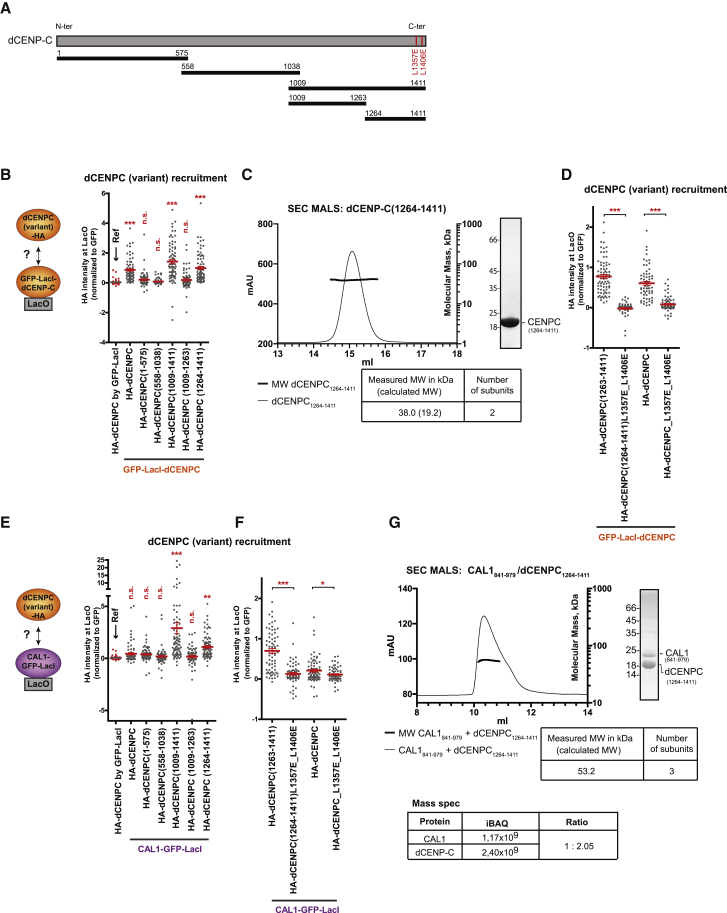
dCENP-C Dimerization Is Necessary to Interact with Monomeric CAL1 to Form a Trimer(A) The dCENP-C N-terminal, middle, and C-terminal regions used in this study are represented by black horizontal lines with numbers indicating amino-acid positions.(B) Experimental scheme and quantitation of normalized HA-tagged dCENP-C and dCENP-C fragment mean intensities at LacO upon tethering of GFP-LacI-dCENP-C or GFP-LacI (first lane).(C) SEC-MALS experiments performed with recombinant His-dCENP-C (1264-1411). Elution volume (ml, x axis) is plotted against absorption at 280 nm (mAu, left y axis) and molecular mass (kDa, right y axis). Tables show measure molecular weight (MW) and calculated MW. Mw/Mn = 1.001.(D) Quantitation of normalized HA-tagged wild-type and mutant dCENP-C fragment mean intensities at LacO upon tethering of GFP-LacI-dCENP-C.(E and F) Experimental scheme (E) and quantitation of normalized HA-tagged dCENP-C and dCENP-C fragment mean intensities at LacO upon tethering of CAL1-GFP-LacI (E and F) or GFP-LacI (E, first lane). (See also Figure S6.) Error bars show SEM (∗p < 0.05; ∗∗p < 0.01; ∗∗∗p < 0.001; n.s., not significant).(G) SEC-MALS experiments performed on the recombinant His-dCENP-C (1264-1411) and CAL1 (841-979) fragment complex. Bottom table shows the ratio of mass-spectroscopy-derived iBAQ peptide intensities of the fragments within the complex.